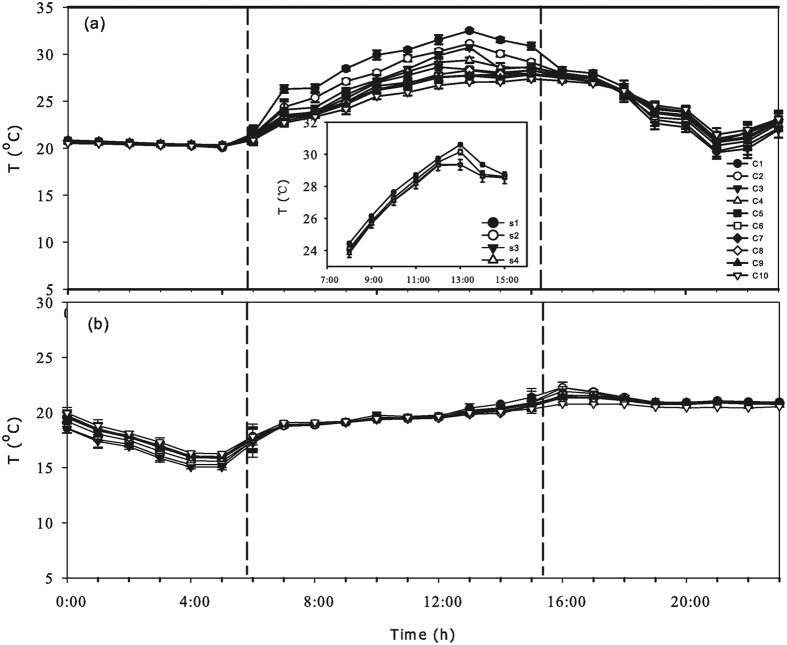
The hourly average air temperature (T) of ten observed areas (C1-C10) during sunny (a) and cloudy (b) conditions in summer. Different symbols are used to indicate different areas: ● = C1, ○ = C2, ▼ = C3, △ = C4, ■ = C5, □ = C6, ♦ = C7, ⋄ = C8, ▲ = C9, ▽ = C10. The inserted figure is hourly average T of sub-areas (s1, s2, s3, s4) at 8:00 to 16:00 during sunny condition. Different symbols are used in inserted figure to indicate different sub-areas: ● = s1, ○ = s2, ▼ = s3, △ = s4. All values are means ± SE; n = 36.